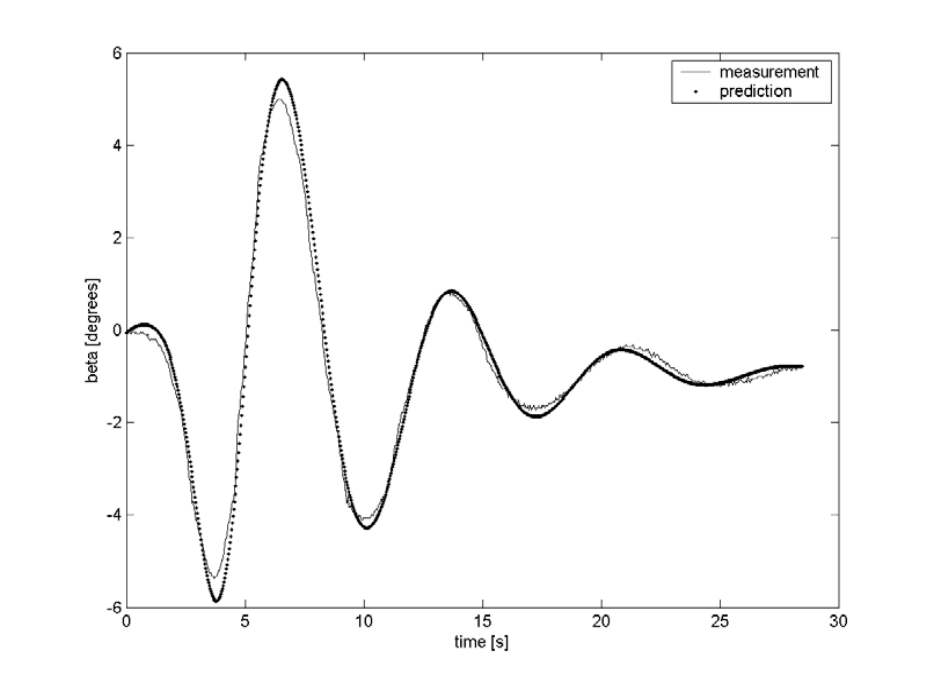
Fig. 8. Measured side slip angle and estimated values.